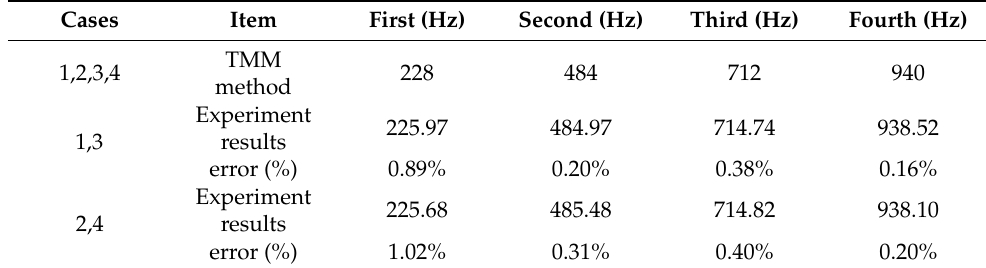
Figure 12. Fluid pressure of pipe outlet. ( a ) Cases 1 and 2. ( b ) Cases 3 and 4. Table 8. Natural frequencies of the fluid pressure of pipe outlet. Table 7. Natural frequencies of the flow velocity of pipe inlet.